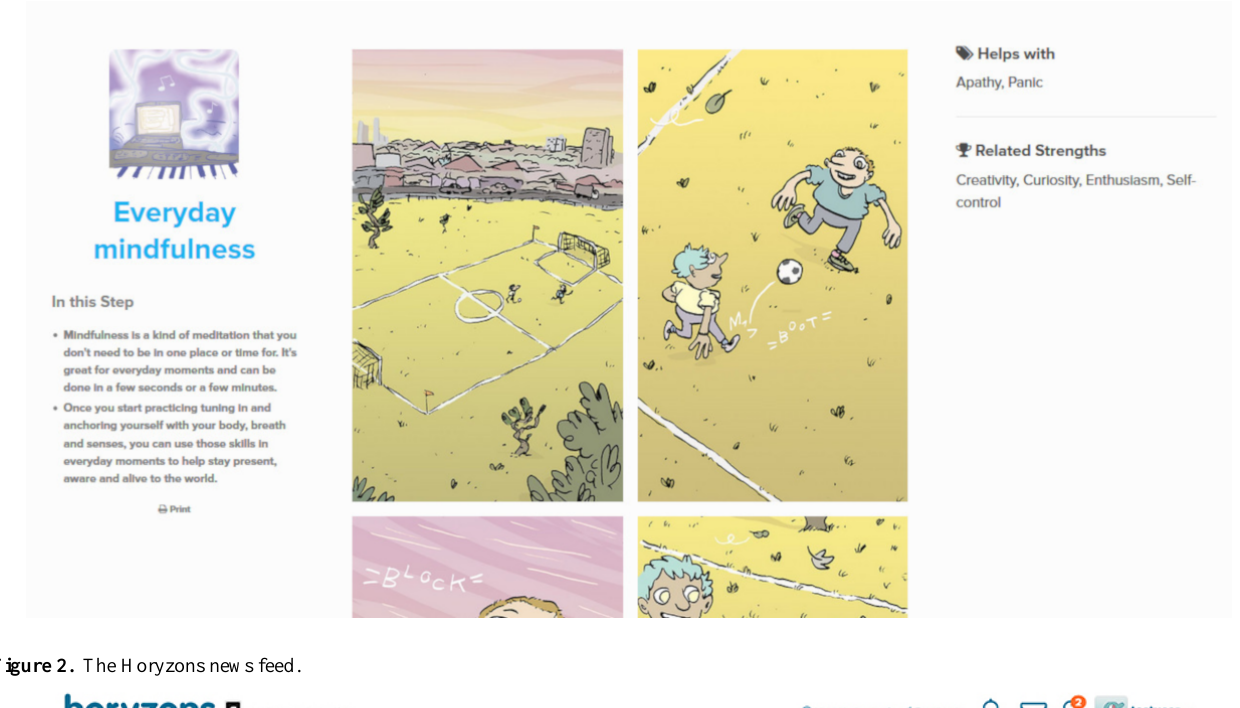
Figure 1. Everyday mindfulness therapy step.